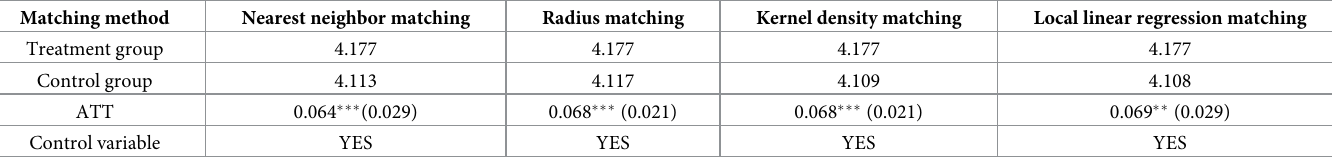
Table 7. Results of the PSM analysis